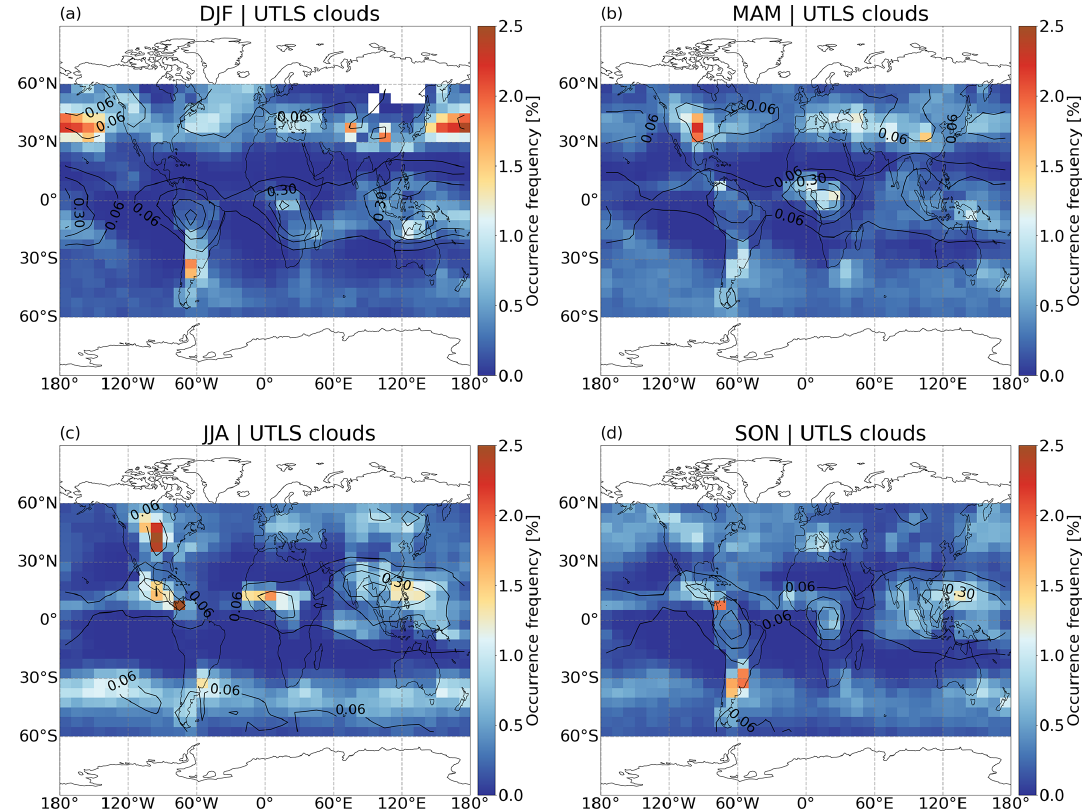
Figure B1. Seasonal mean occurrence frequency of UTLS clouds derived from AIRS measurements during 2007–2019. Black contours are the occurrence frequencies of SICs, as shown in Fig.